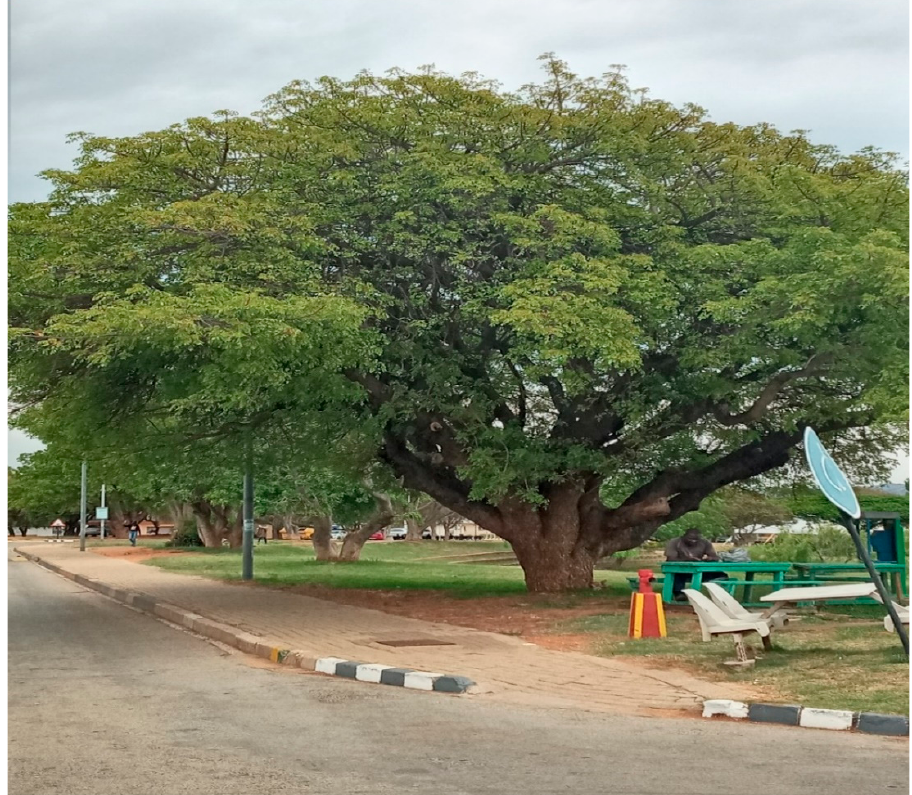
Figure 1. Morula tree at the University of Limpopo, South Africa (Source: image taken in October 2021 by Author). 2021 by